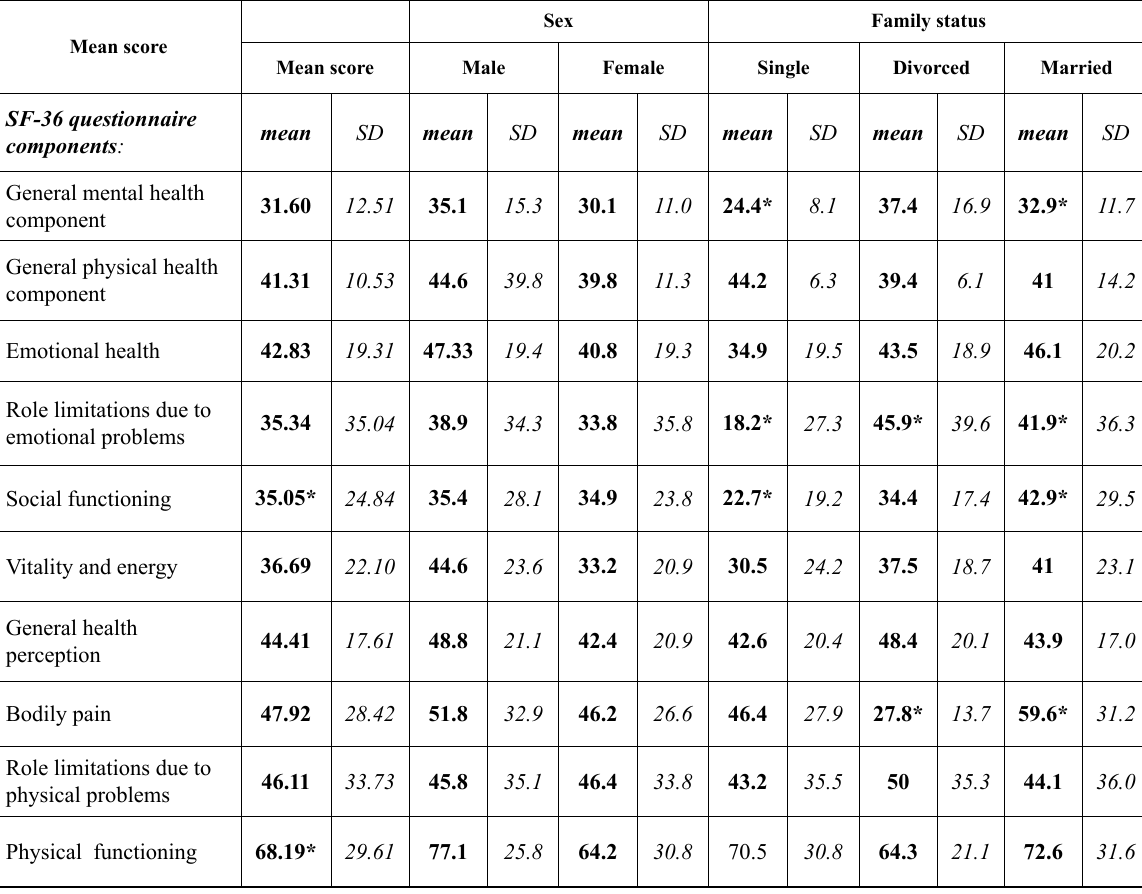
Note. *statistically significant difference of indicators, p <